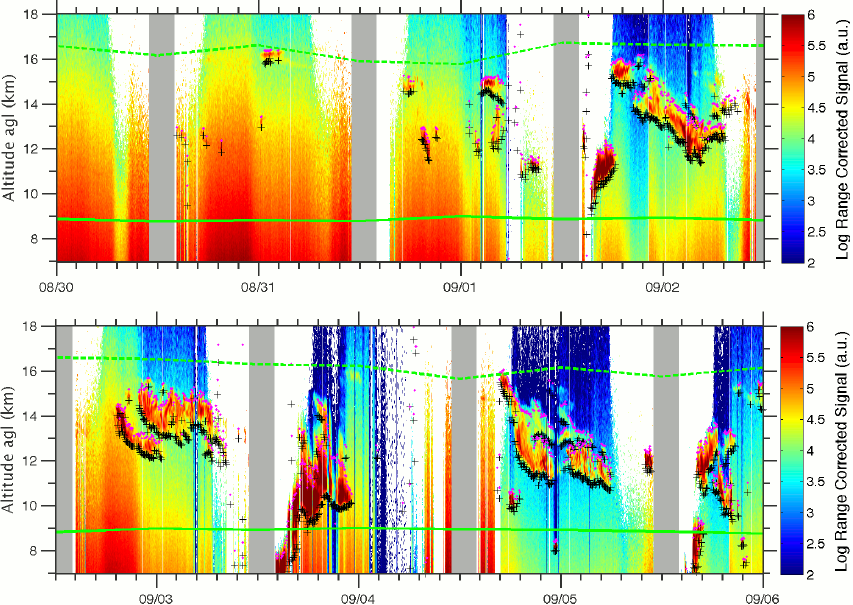
Figure 18. Logarithm of range corrected signal above 7km is shown from 30 August to 6 September 2011 divided into two panels for depicting the high clouds. Cloud base (+, black) and top (o, magenta) detected by our algorithm are indicated with markers. Full and dashed green lines indicate the − 25 ◦ C and trotopause heights calculated from the radiosondes. Gray regions correspond to local solar.